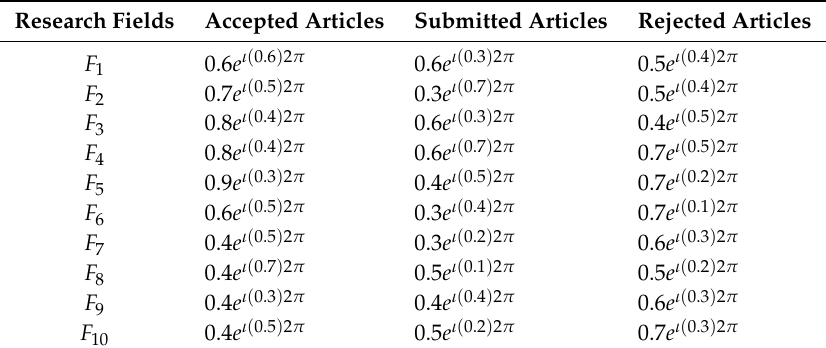
Table 4. Periodic behavior of research